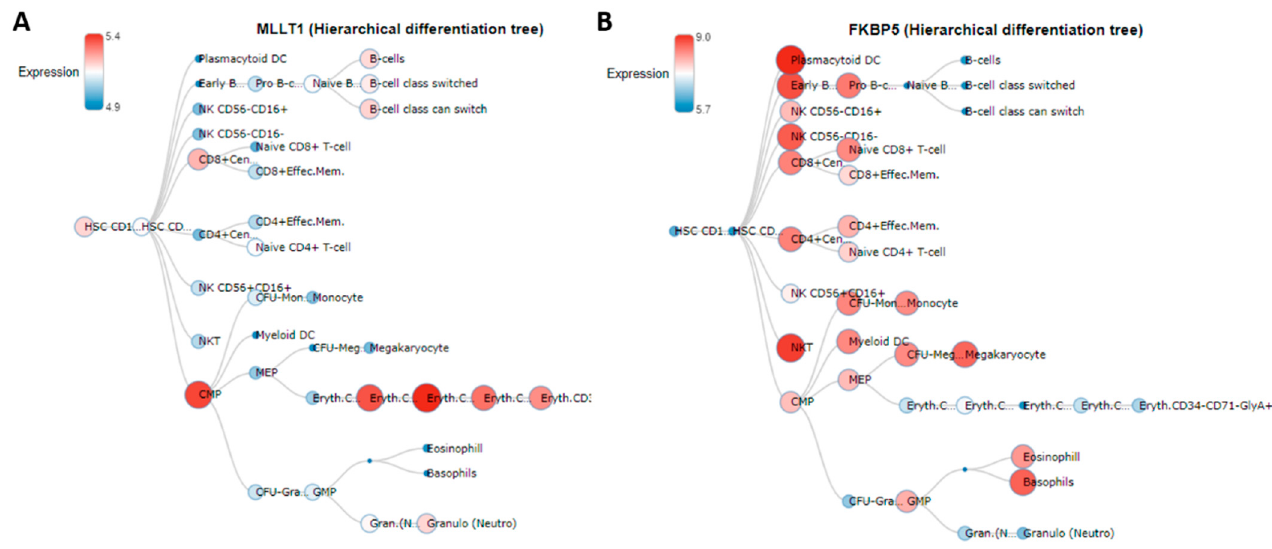
Figure 2. Expression profiles in normal human haematopoiesis. MLLT1 ( A ) and FKBP5 ( B ) expression profiles in normal human haematopoiesis as reported in the Blood Spot database (http://servers.binf.ku.dk/bloodspot/, accessed on 26 May 2021).